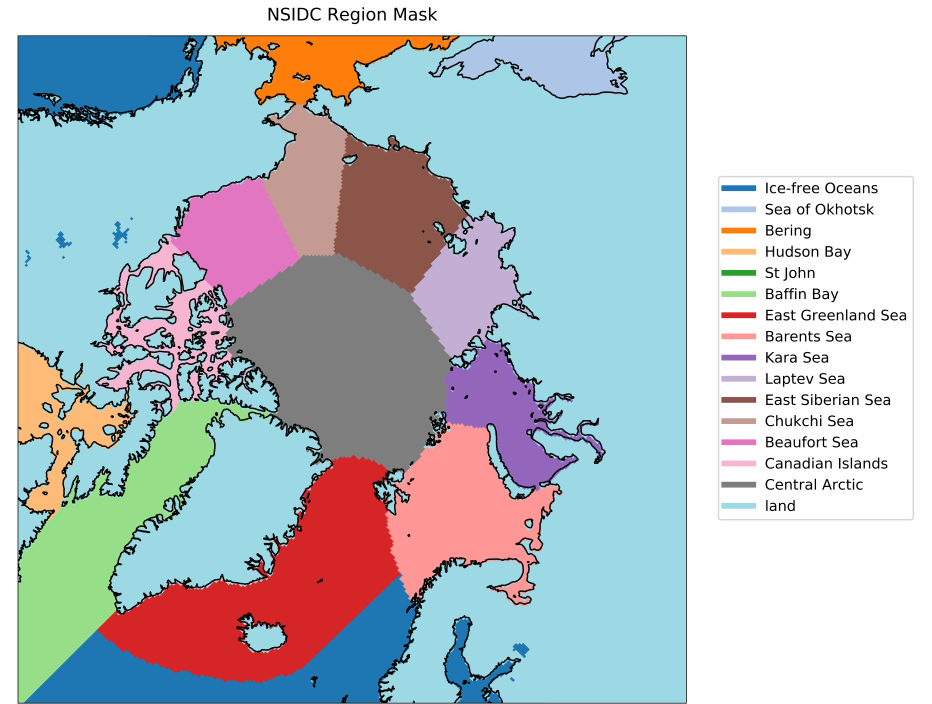
Figure A1. A map of the NSIDC region mask, defining the regions and extents used in this paper.